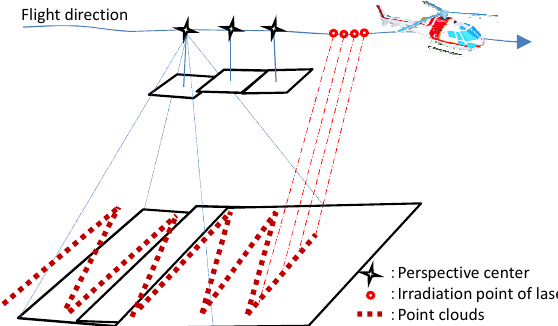
Figure 2. Measurement